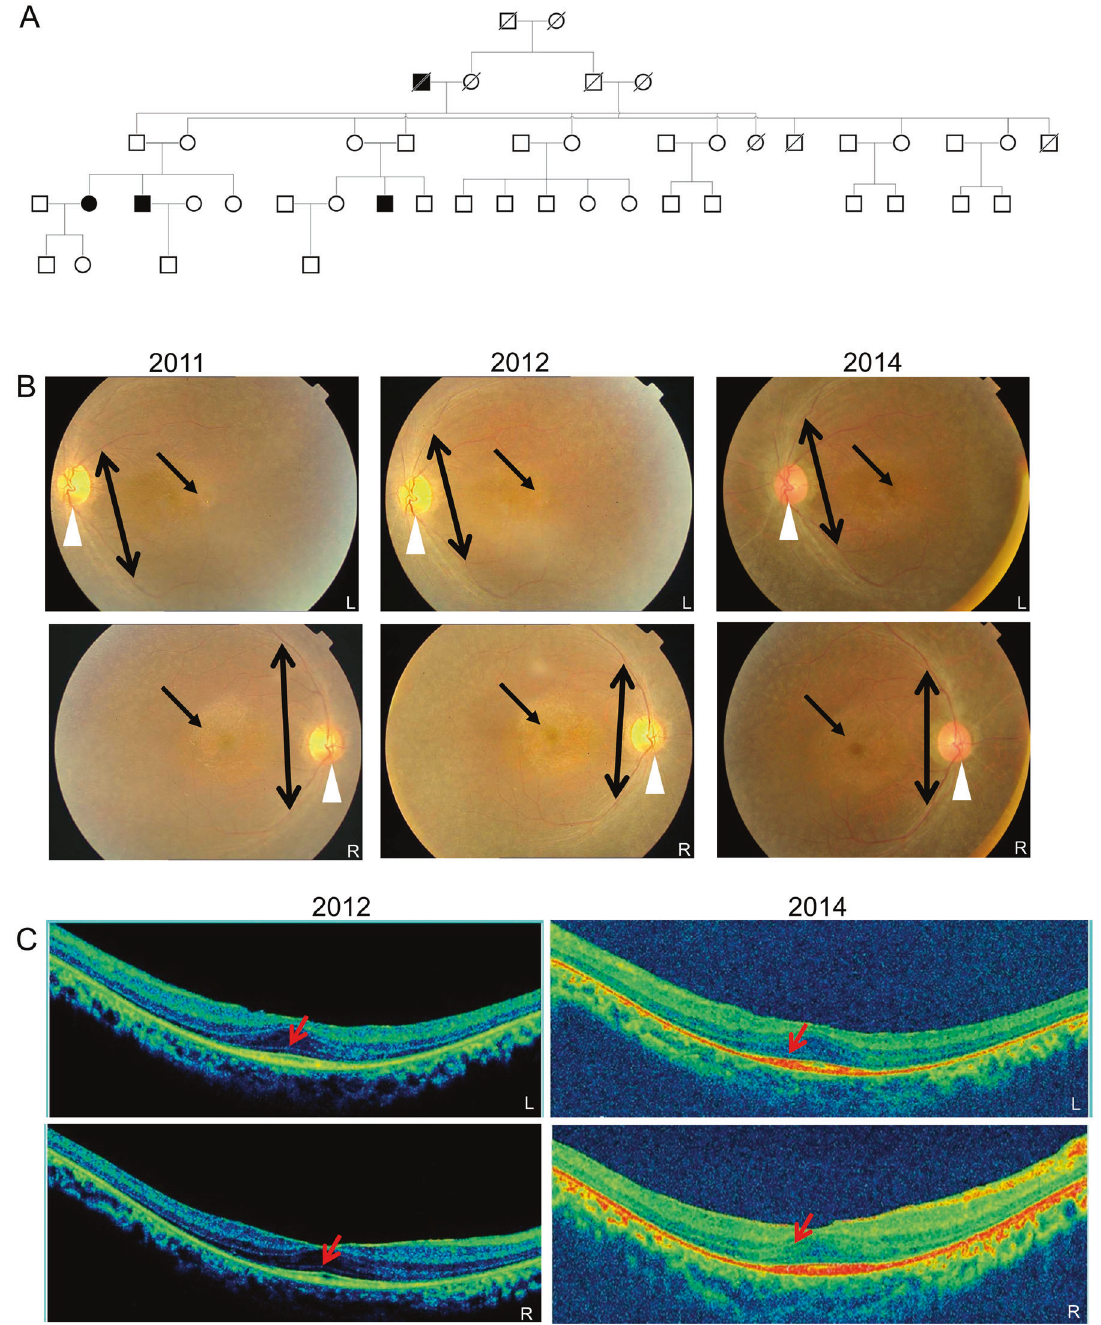
Fig. 1 Pedigree and retinal imaging of the DKRRP2 family. A Five generation pedigree denoting the presence of ocular disease. Males and females, are represented by squares and circles, respectively. The symbols of affected family members are fi lled. B Fundus images of the proband ’ s left (L) and right (R) eye taken at the time of case registration 2011, on follow-up 2012 and again in 2014. Waxy pallor disc (marked by white arrow head), pigmentary deposits (marked by one sided arrow) and attenuated arterioles (marked by double sided arrow). C SD-OCT images of the proband ’ s retinal layers: left (L) and right eye (R) were taken on follow-up 2012 (left two panels) and follow-up 2014 (right two panels). Mild central hyper re fl ectivity suspicious of scars were marked with arrows. Thinning of the retinal layers was was lost in the mutant. Degeneration slowed after PM7, SD-OCT evaluation of the entire photoreceptor length, measured culminating in an almost complete loss of the PhR + layer at as the combined thickness of the outer segment and the ONL PM12, and only the inner nuclear (INL) and ganglion cell (GCL) layer (hereafter referred to as photoreceptor plus or PhR + ), layers remained (Fig. 6E, F). However, at PM12 the appearance of revealed an initial loss of 15 – 20% of the PhR + layer at PW3, PW4 the INL nuclei starts to be more scattered, suggesting the and PM2 (Fig. 6F). While the PhR + layer thickness remained stable appearance of secondary morphological changes in this inner in the healthy control, it steadily declined over time in the Cnga1 retinal layer. mutant (Fig. 6F). Between PM5 and PM6 half of the PhR + layer